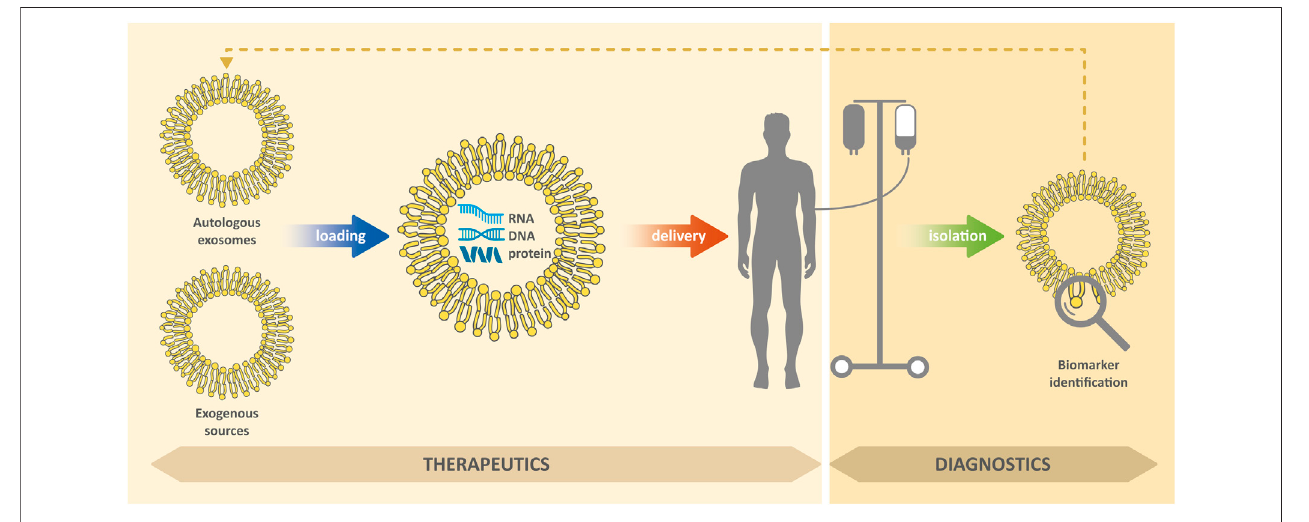
FIGURE 2 | Exosomes for diagnostic or therapeutic